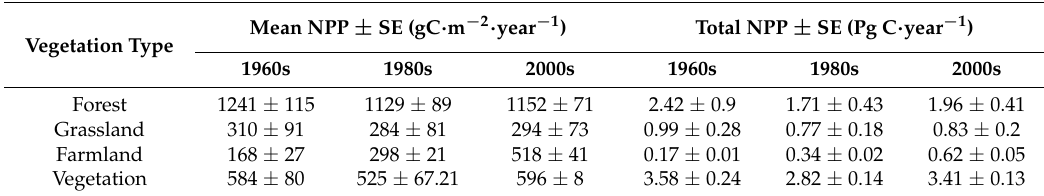
Table 2. Estimation of average NPP and total NPP from the 1960s to the